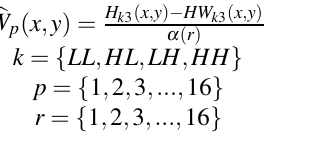
Figure 4: Partitioning of 3-DWT